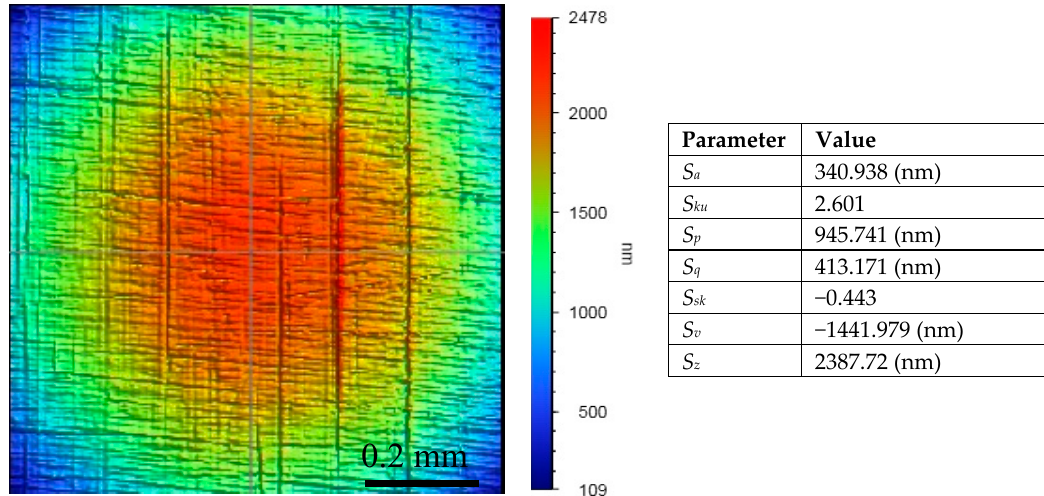
Figure 2. Surface profile of an untreated pressure ring. Surface roughness parameters are given in the right table.